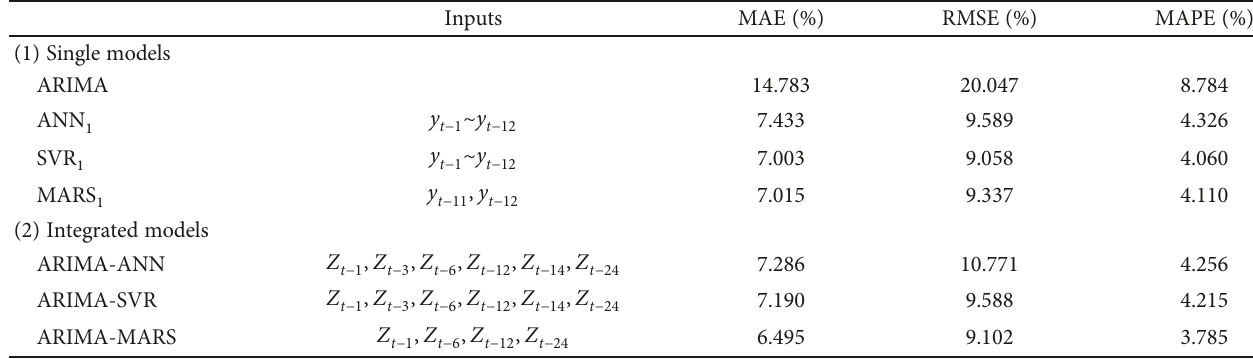
Table 18: Performance comparison of various models for corn price